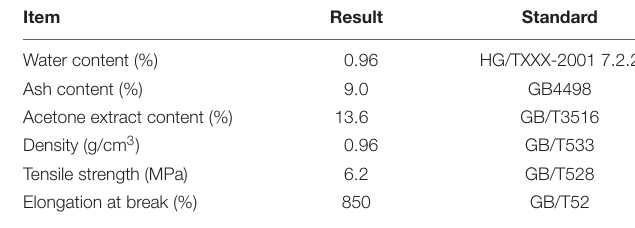
TABLE 2 | Properties of crumb